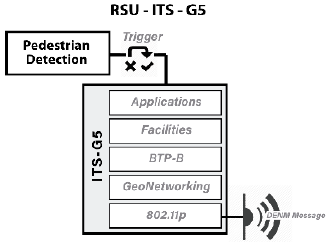
Figure 4. RSU ITS-G5 decentralized environmental notification messages (DENM) creation.